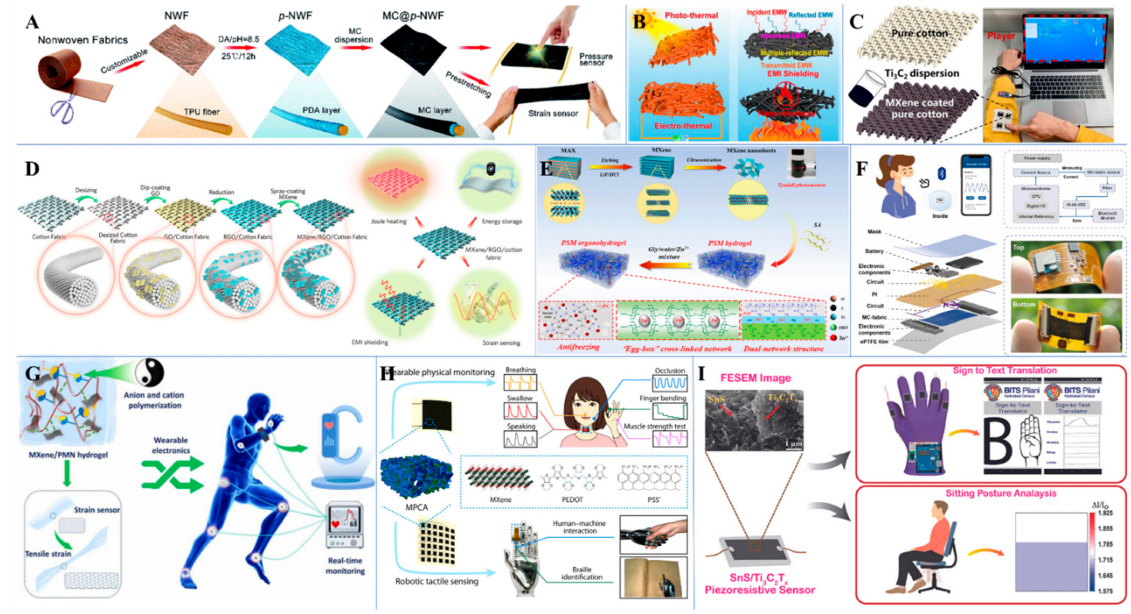
Figure 7. ( A ) Schematic diagram of the preparation of MXene@ polyurethane non-woven fabric for tunable wearable strain/pressure sensor. Reprinted with permission from Ref. [134]. Copyright